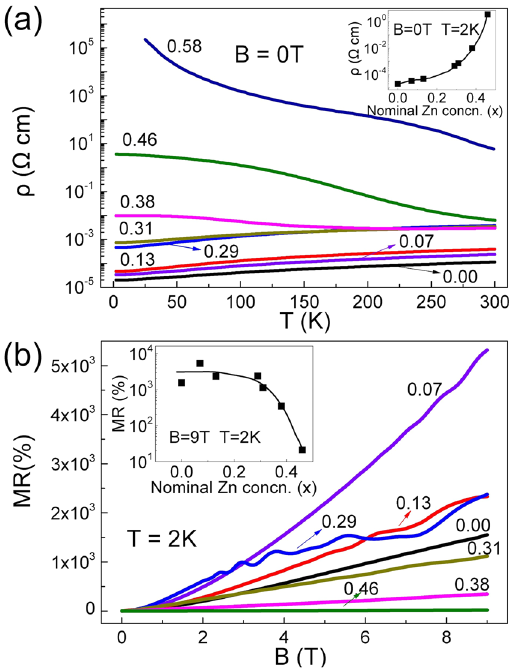
Figure 4. Panel (a): Temperature dependent resistivity of (Cd 1 − x Zn x ) 3 As 2 for 0 ≤ x ≤ 0.58 in zero magnetic field. Inset: The values of resistivity for 0 ≤ x ≤ 0.46 at 2 K in zero magnetic field. Panel (b): MR versus magnetic fields at 2 K. Inset: The values of MR for (Cd 1 − x Zn x ) 3 As 2 (0 ≤ x ≤ 0.58) versus x at 9 T at 2